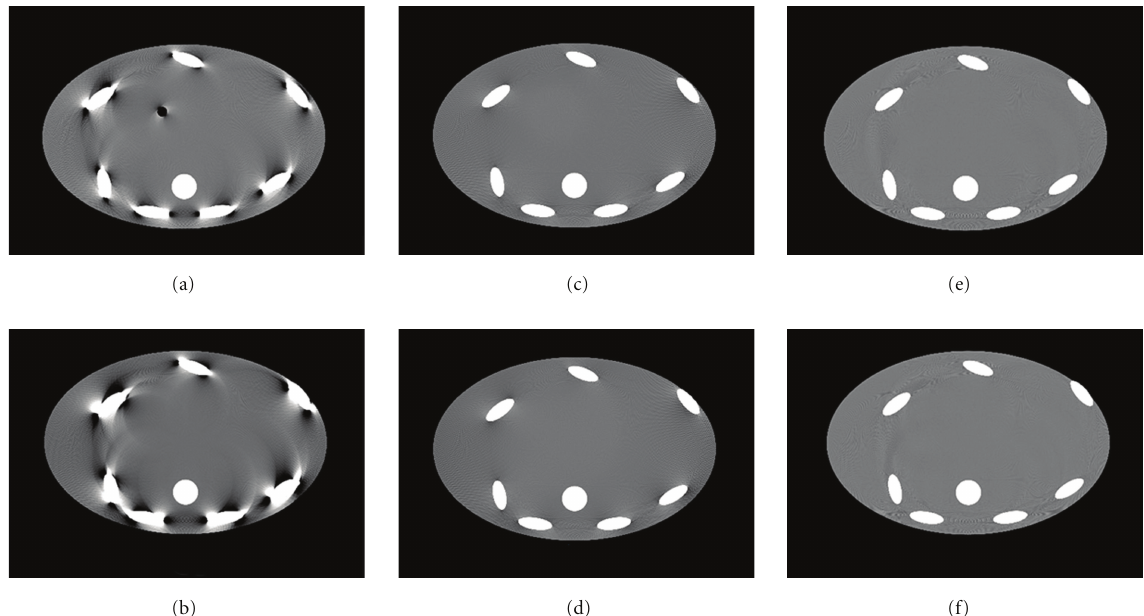
Figure 11: Worst-case images from (a) 3rd generation CT system with 40 mm coverage, (b) 3rd generation CT system with 80 mm coverage, reconstructed with FDK, (c) multi-axial acquisition CT system with 120mm coverage, (d) multi-axial acquisition CT system with 160 mm coverage, reconstructed with slice substitution approach, using FDK slices, (e) multi-axial acquisition CT system with 120 mm coverage, and (f) multi-axial acquisition CT system with 160mm coverage, reconstructed with TOM window-based reconstruction. Grayscale: ( − 50HU, 50HU). Note that the worst-case slices for 3rd generation system are the slices located at the edge of scan FOV, and the worst-case slices for multi-axial acquisition system are the slices located in between two sources.